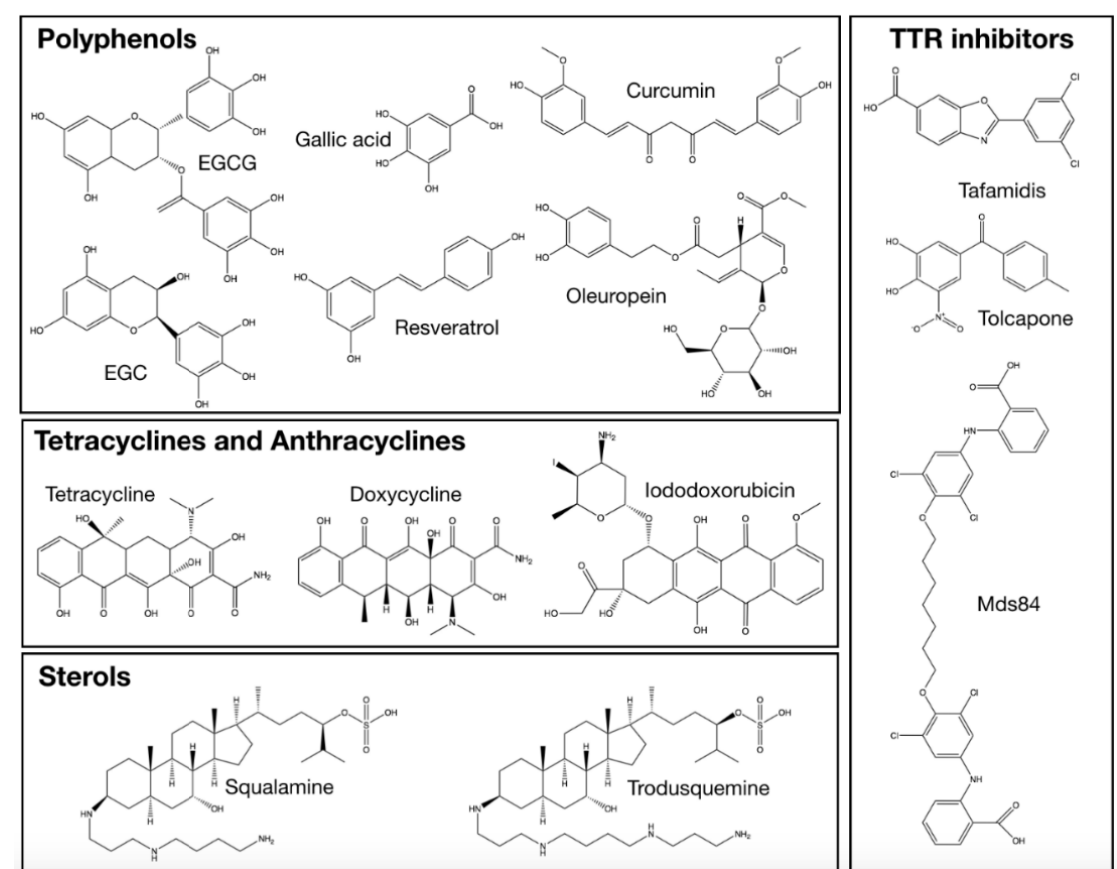
Figure 2. Chemical structures of the antiamyloid compounds discussed in the present review. Table 1. A compilation of anti-aggregation compounds against amyloid diseases.